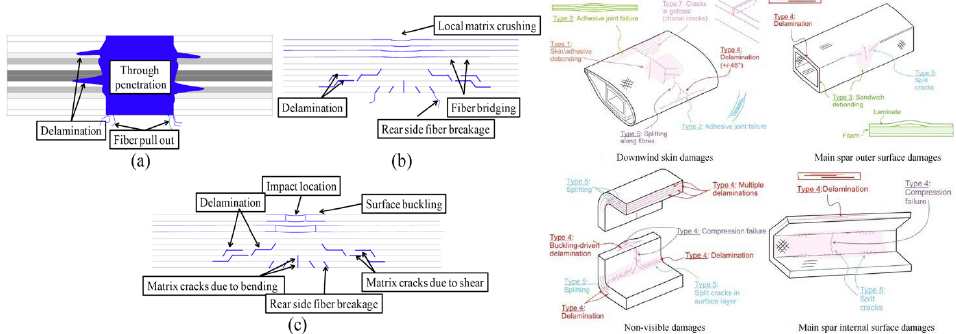
Figure 5. Different types of defects. Deterioration mechanisms caused by impact loading ( a ) higher, ( b ) medium and ( c ) lower [19].